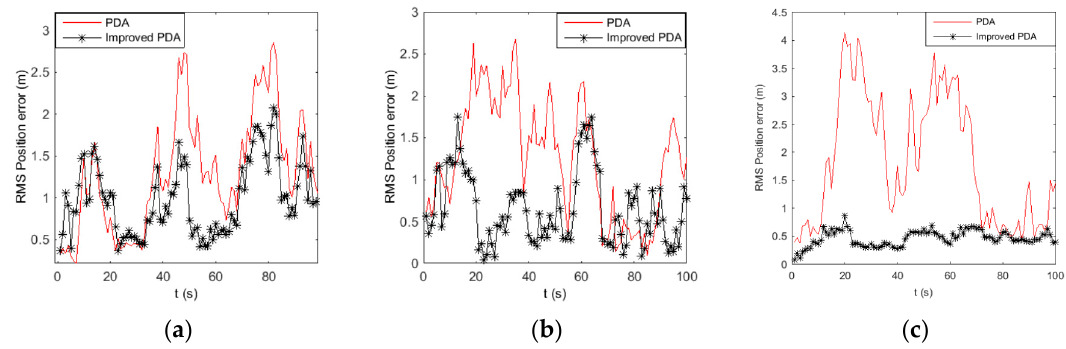
Figure 1. RMS position error statistics using PDA and improved PDA in different density clutter.